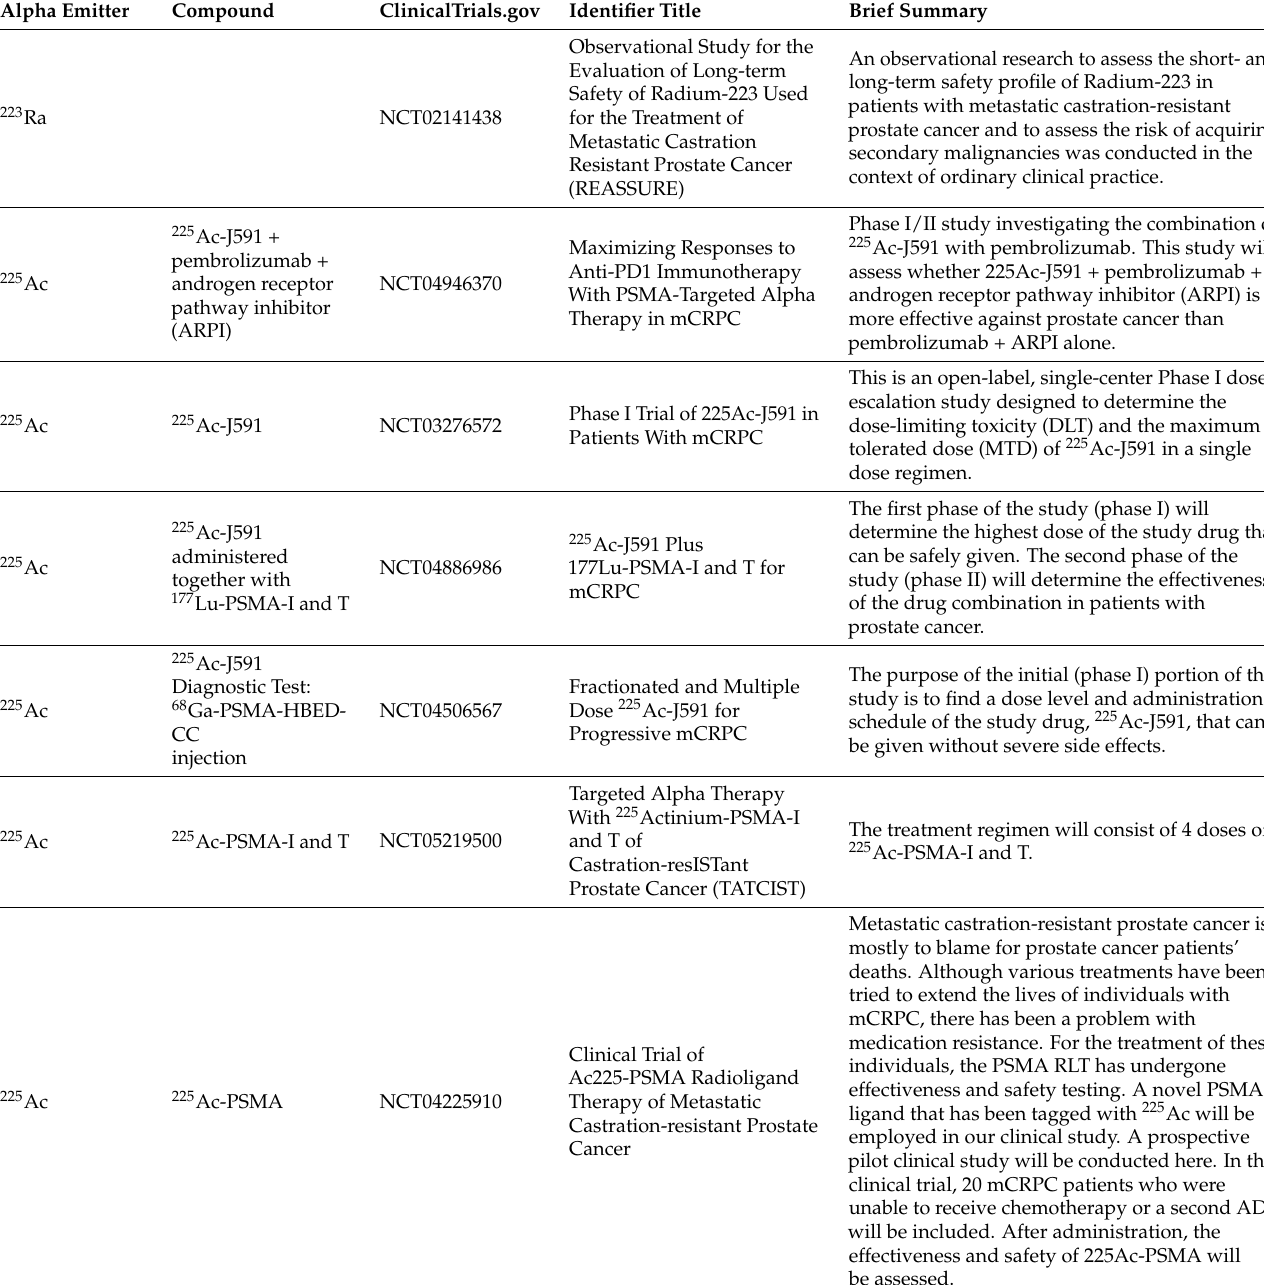
Table 1. An overview of ongoing studies in clinical trials (“alpha emitter” in “prostate cancer”, “225Ac” in “prostate cancer”, “213Bi” in “prostate cancer” as registered on the ClinicalTrials.gov platform (https://clinicaltrials.gov/; last accessed on 20 September